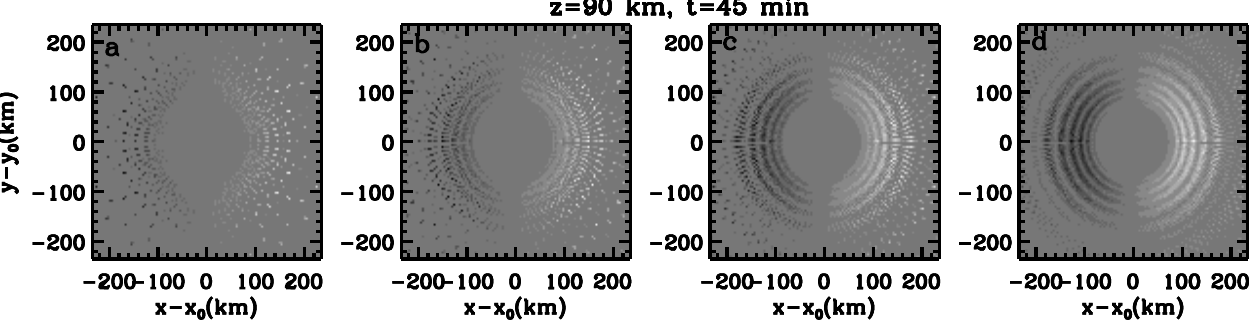
Fig. 8. Zonal flux of vertical momentum at z = 90km and t = 45min from ray tracing the excited GW spectra from a single convective plume with reflection. The GW spectra used in (a) , (b) , (c) , and (d) are those shown in Fig. 7a, b, c, and d,